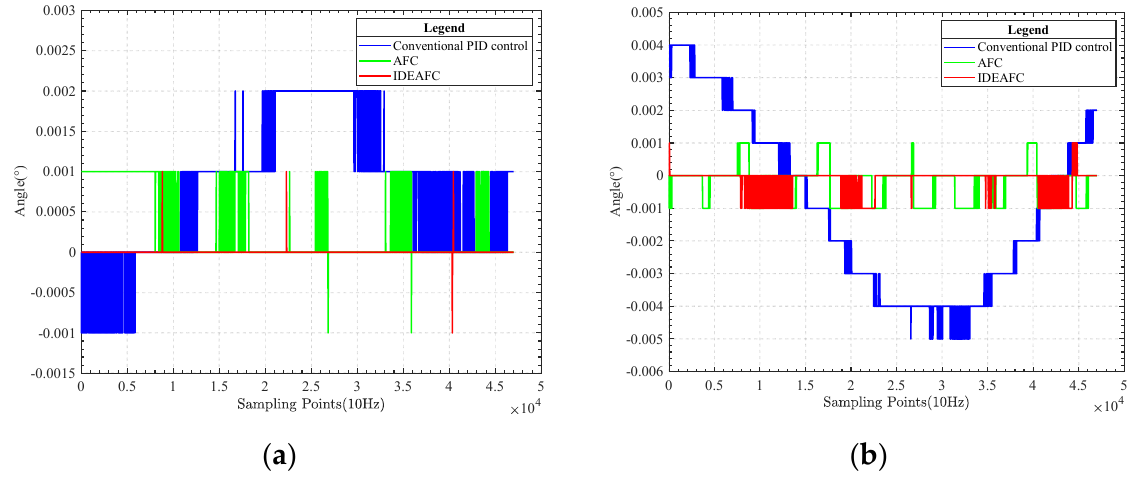
Figure 12. ( a ) Comparison of pitching angle data; ( b ) comparison of rolling angle data.